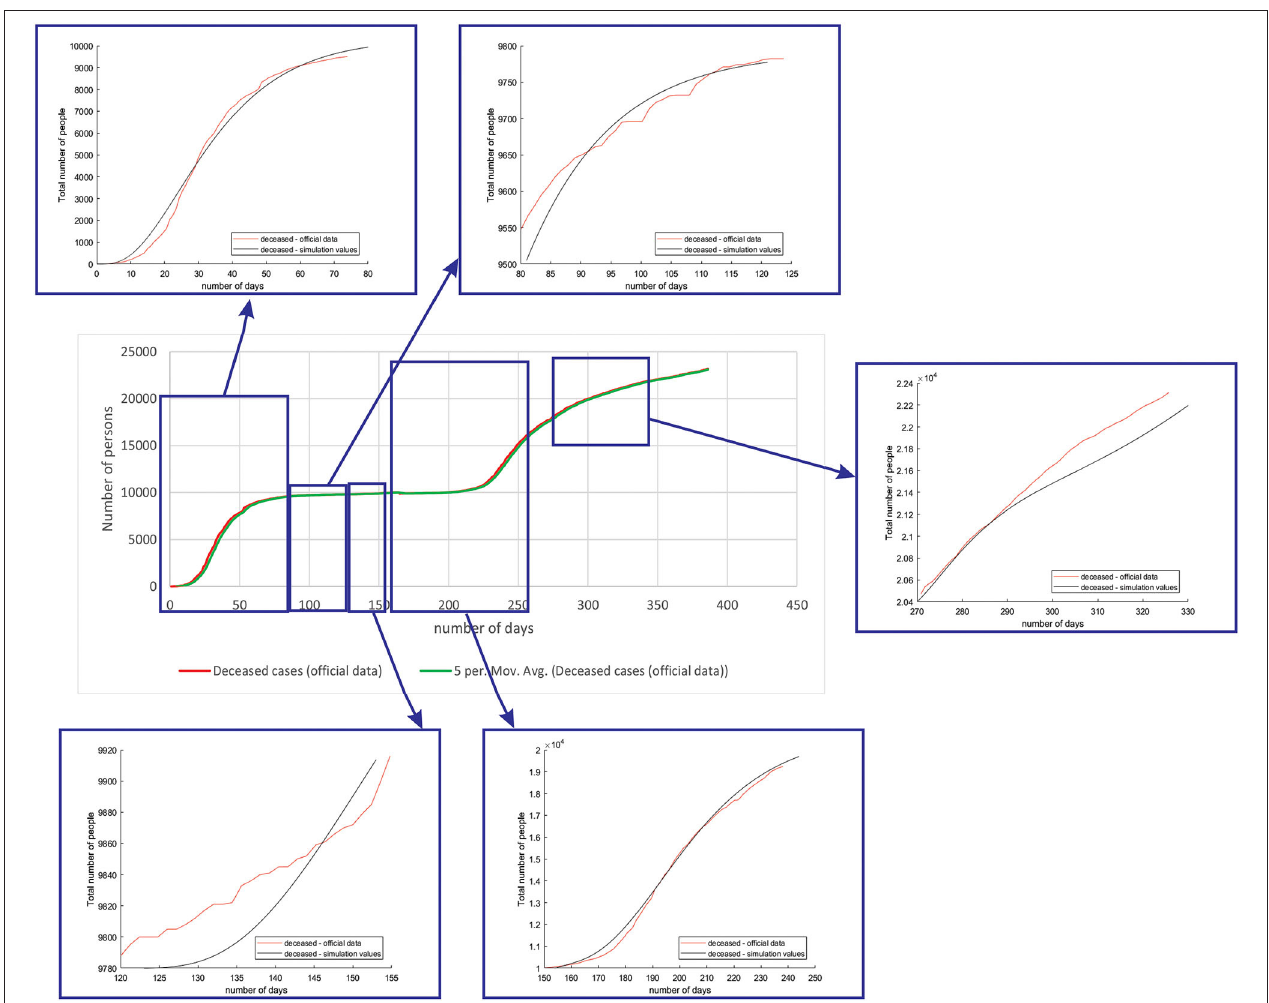
FIGURE 7 | Comparison between the real and simulated values for deceased cases in Belgium using the proposed SEIRD